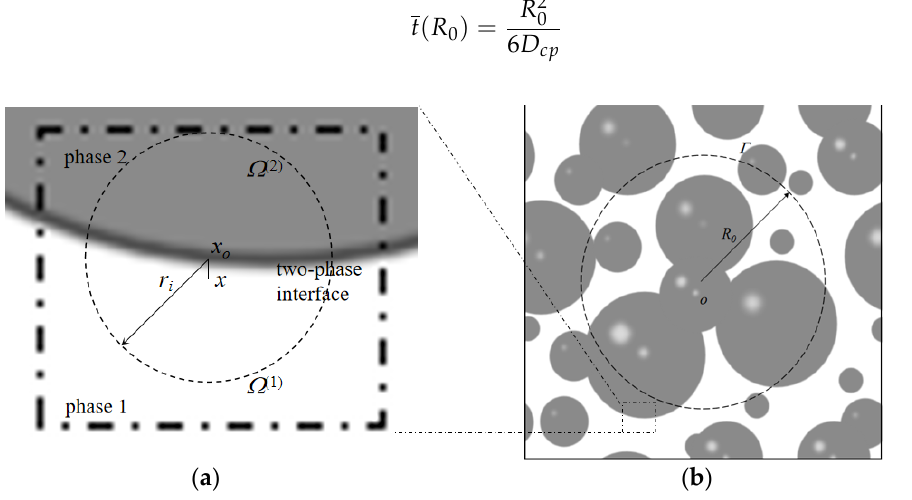
Figure 6. Brownian particles walking in cement paste: ( a ) two-phase interface; ( b ) two-phase cement